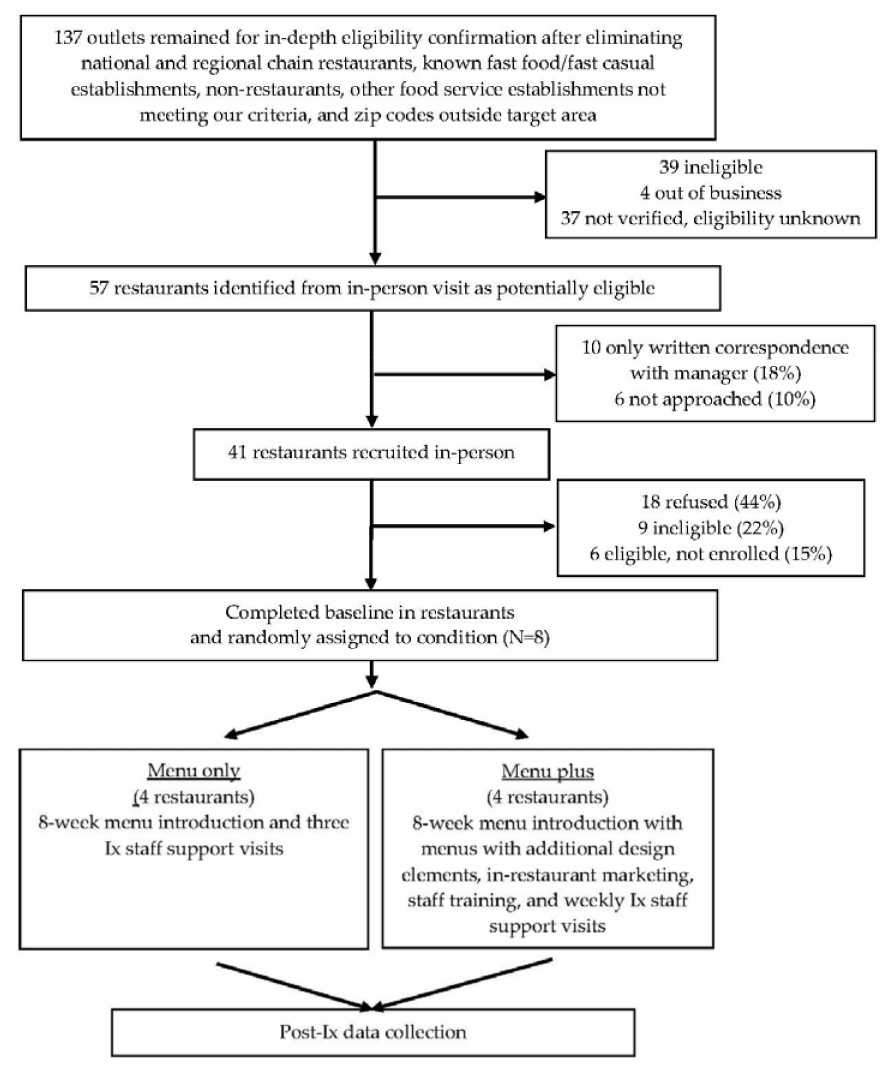
Figure 1. CONSORT figure for Kids’ Choice Restaurant Program